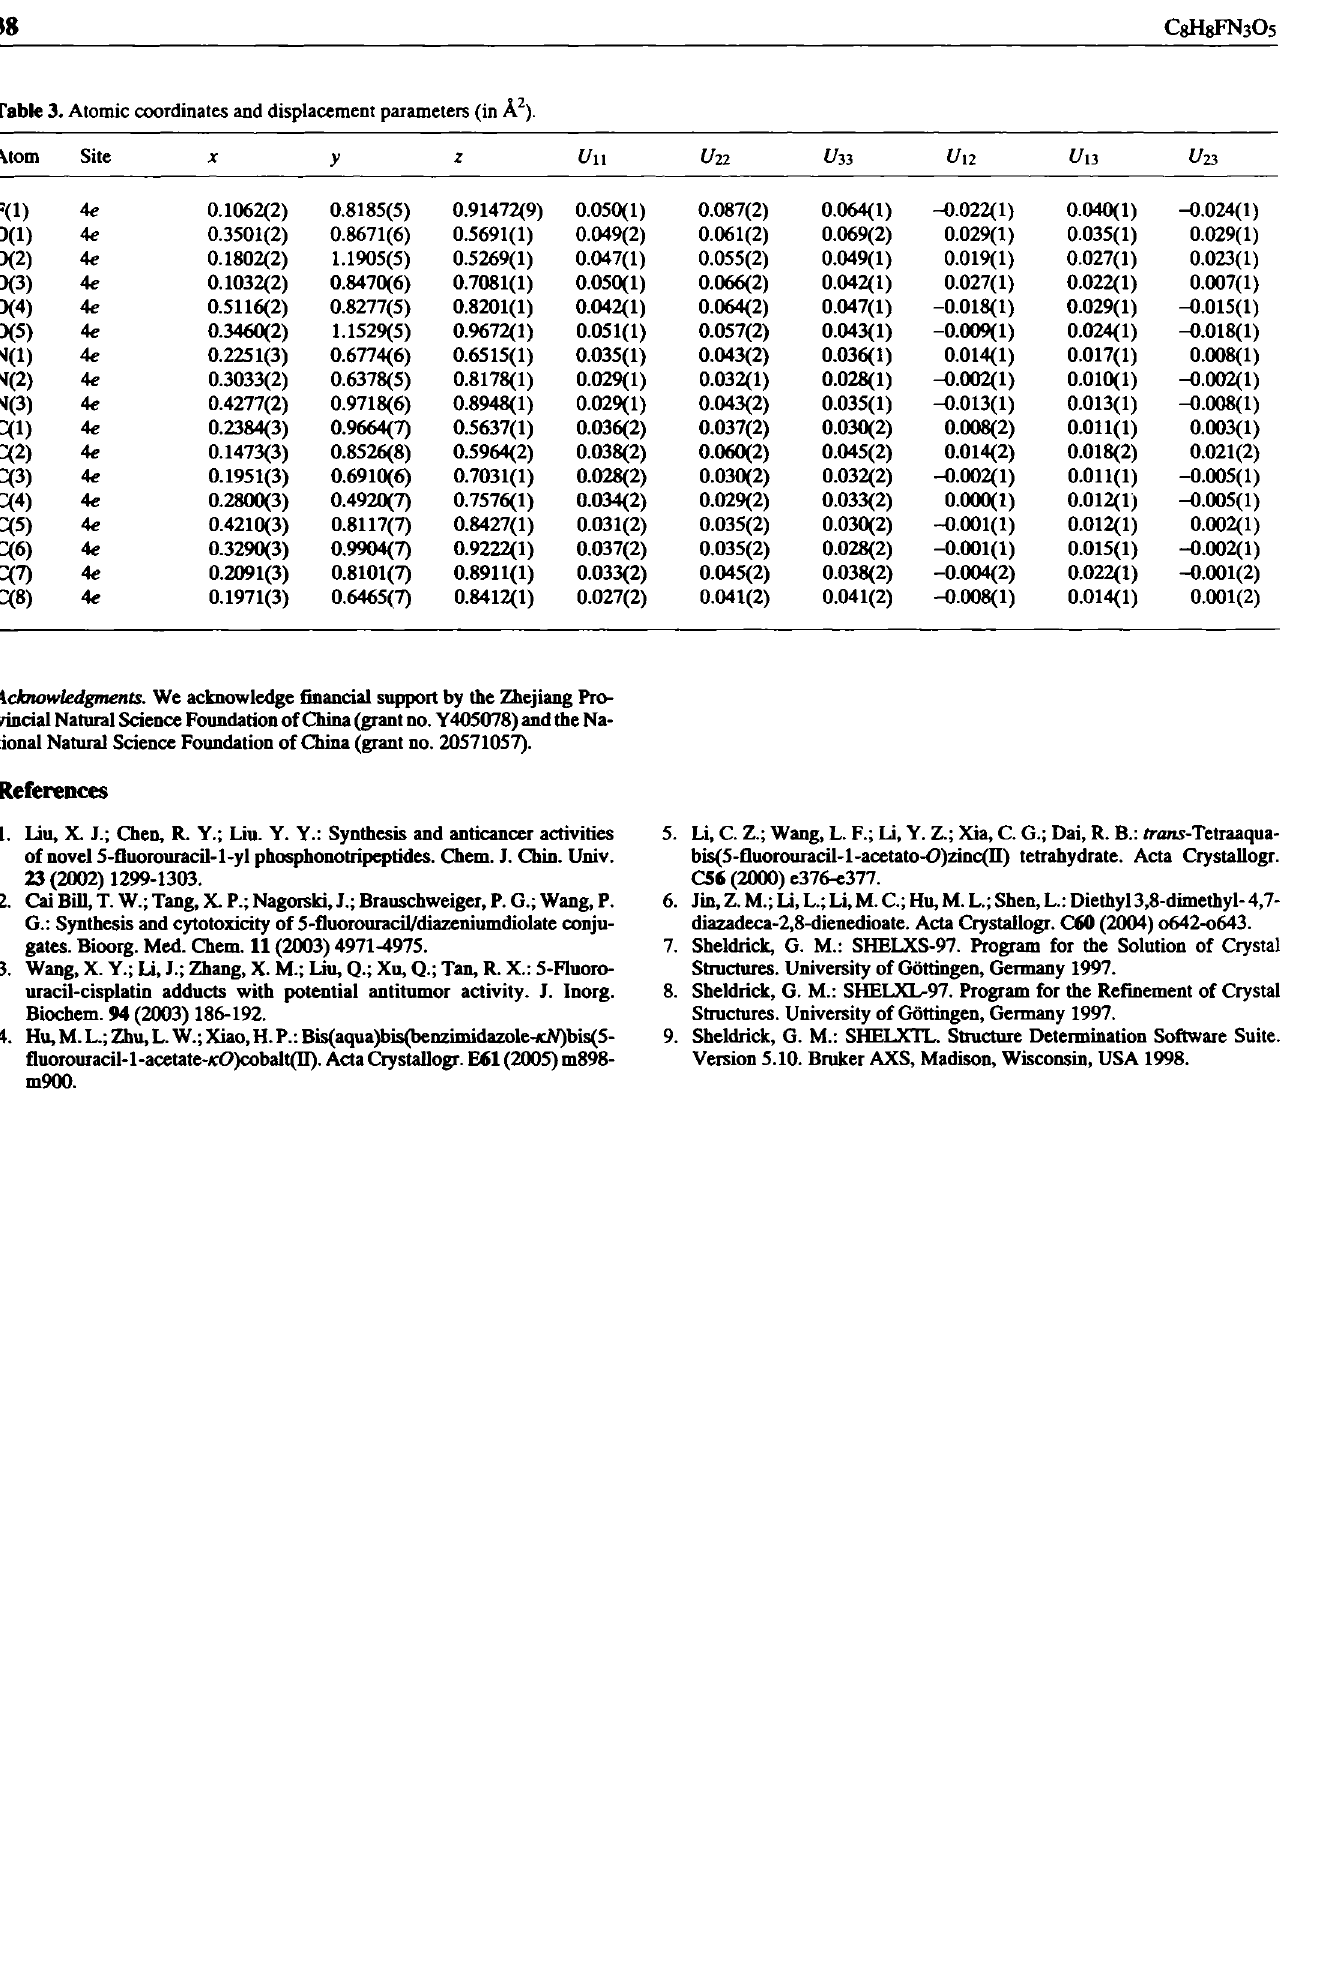
Table 3. Atomic coordinates and displacement parameters (in A 2